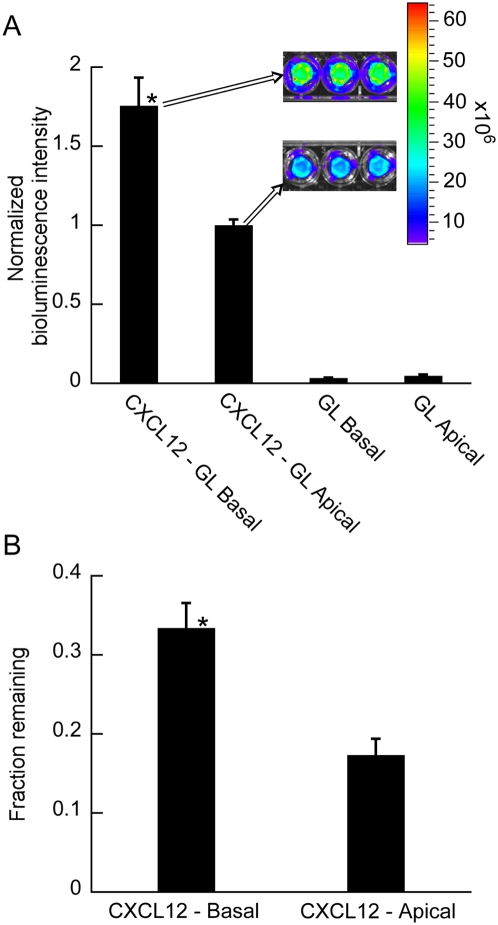
Enhanced binding of CXCL12 presented to the basal versus apical surface of endothelium mediates increased adhesion of cancer cells.(A) HDMEC cells 2 cultured on transwell inserts were incubated with ≈ 40 ng ml−1 CXCL12-GL added to either the top (apical) or bottom (basal) compartment for 5 hours. Control wells were incubated with equal amount of unfused GL (based on ioluminescence) added to either the top or bottom compartment. Cell-associated luciferase activity from CXCL12-GL or GL was quantified by bioluminescence imaging. Data are mean values combined from two independent experiments (n = 4, 5 for each condition). Inset shows representative bioluminescence images of CXCL12-GL associated with endothelial cells. Images are presented as a pseudocolor display with red and blue depicting the highest and lowest levels of photons, respectively. Note, 40 ng ml−1 is the highest concentration of CXCL12-GL that we can collect. (b) HDMECs in transwells were treated with 100 ng ml−1 CXCL12 either apically or basally. Following incubation with 231-control cancer cells and subsequent washing to remove non-adherent cells, approximately twice as many cancer cells remain adhered onto endothelium treated with CXCL12 basally versus apically. The fraction of cells that remain adhered was calculated from the number of cancer cells added into empty wells from the same cell suspension. n = 36 for each condition. *, p<0.05.